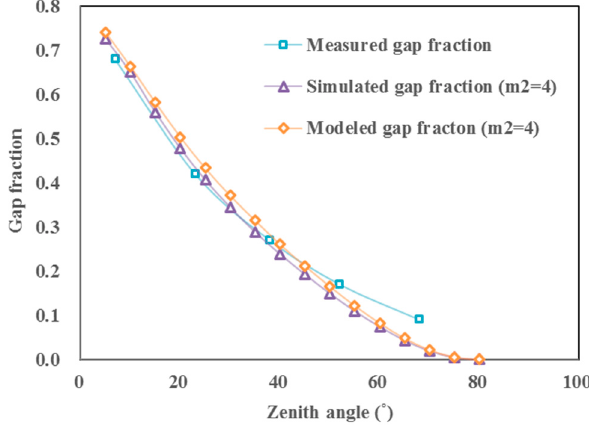
Figure 7. Measured and simulated gap fraction from an old black spruce forest, near Candle Lake, Saskatchewan. Parameters are referred to Column 1 in Table 2.